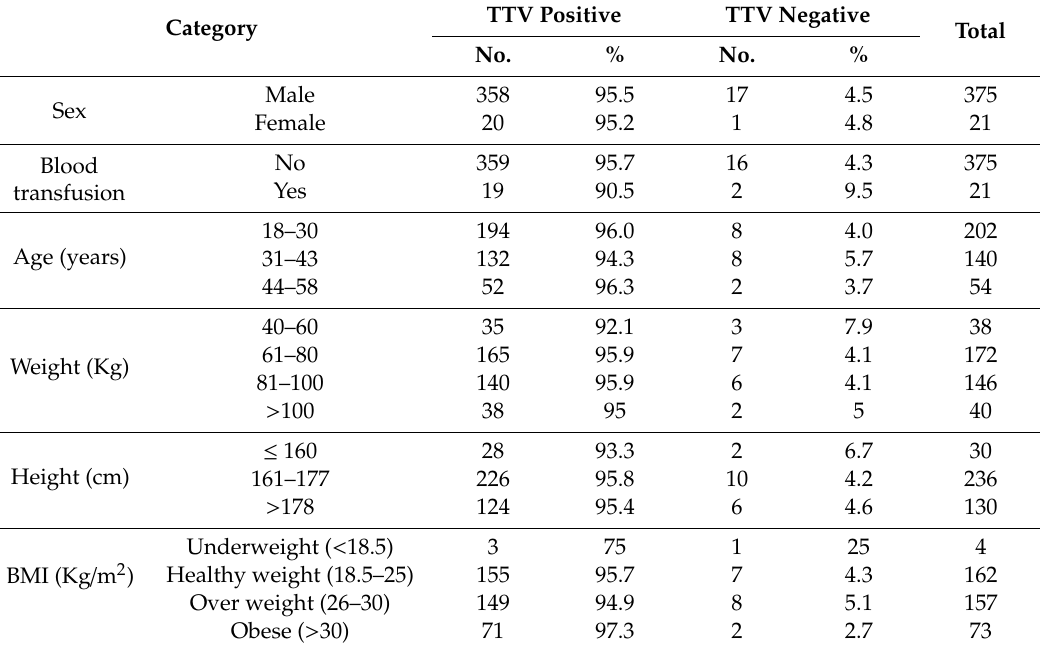
Table 3. Demographic characteristics of Jordanian blood donors.